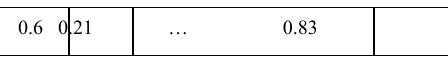
Figure 4. Structure of the countries in the NLICA algorithm.